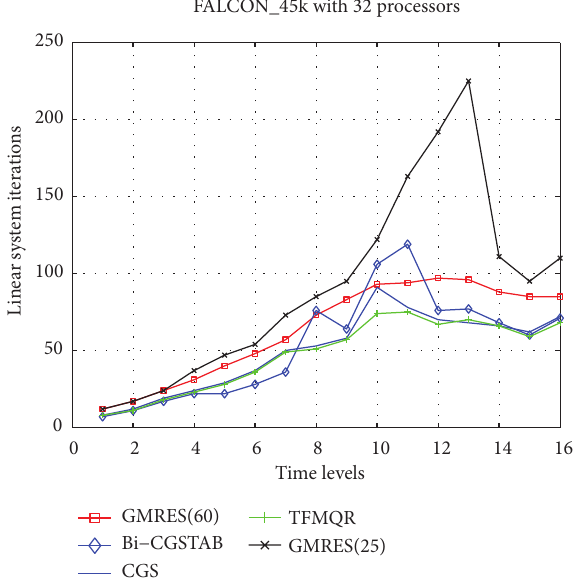
F 6: FALCON aircra. Comparison of number of iterations per time level for 32